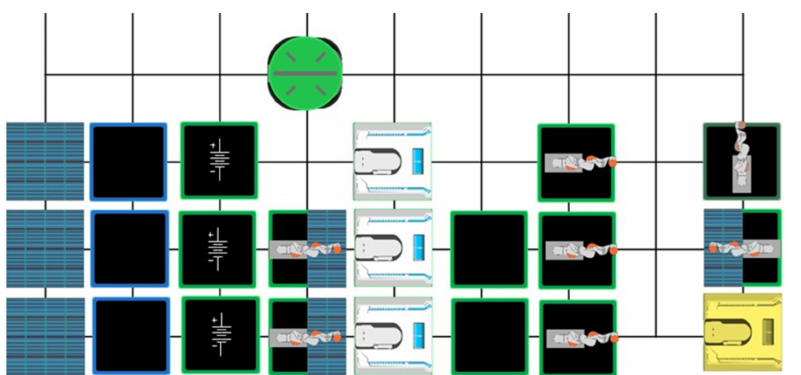
Figure 7. A combined solution for the distribution of modular platforms.